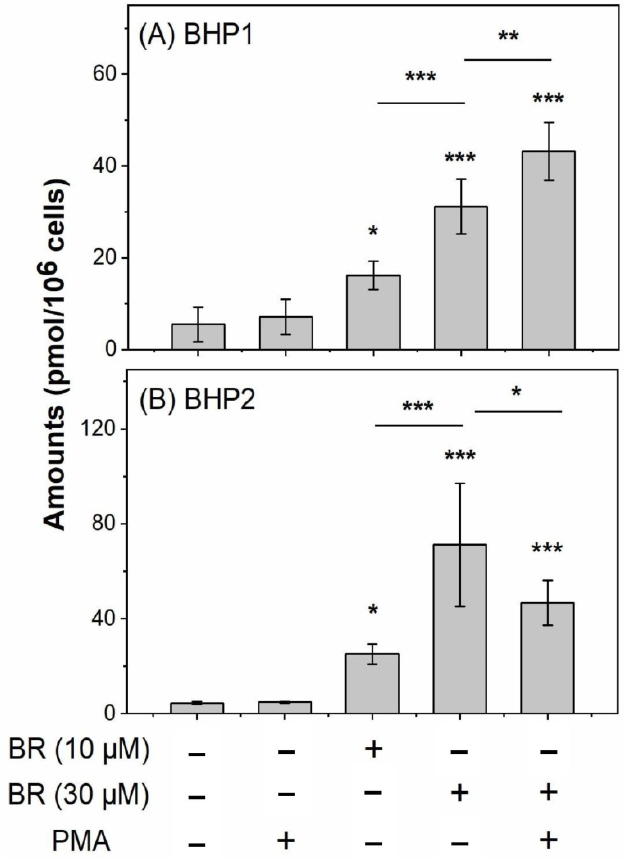
Figure 3. BR degradation in murine neutrophils to form ( A ) BHP1 and ( B ) BHP2. Neutrophils were incubated with BR (10 or 30 µ M) for 1 h, and then PMA was added to 30 µ M BR-treated cells at a final concentration of 1 µ M. After incubation for 2 h, cells were lysed and subject to LC-MS/MS analyses. The data were presented as means ± standard deviation (SD) ( n = 6 except for the negative control ( n = 4), * p < 0.05, ** p < 0.01, *** p < 0.001; BR, bilirubin; PMA, phorbol-12-myristate-13- ac- etate).